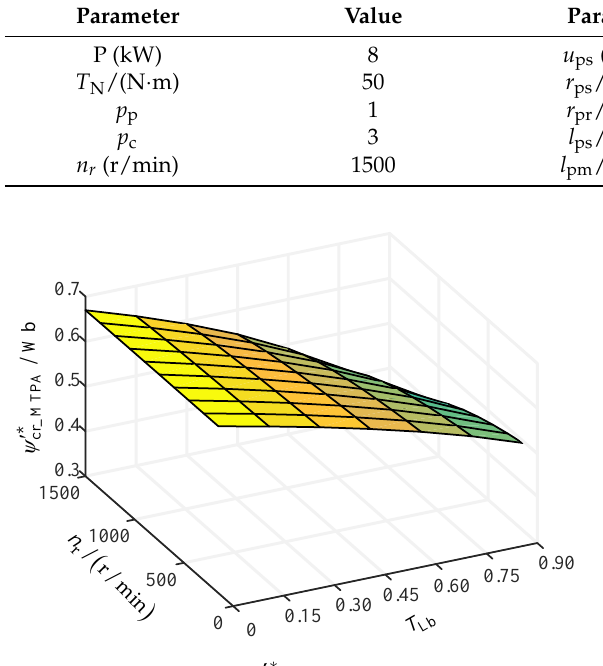
∗ when the speed and torque cr_MTPA when the speed and torque vary. c r _ M T P A